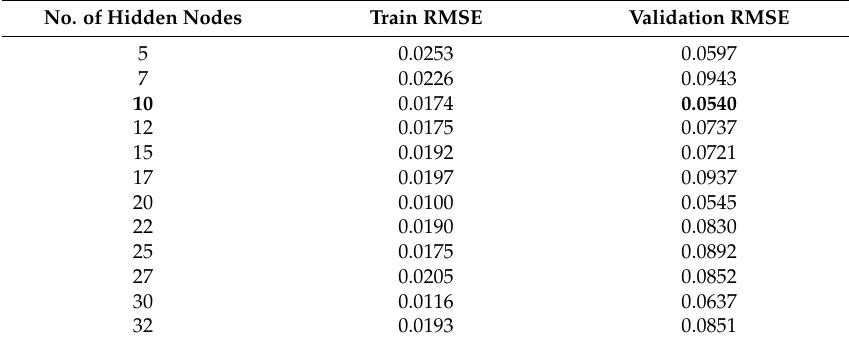
Figure 10. Comparison of error in modeling the % of inhibition on the test data using the partial least squares regression (PLS) and the artificial neural network method. Table 5. Performance comparison of a single hidden layer neural network by varying the number of nodes in the hidden layer.